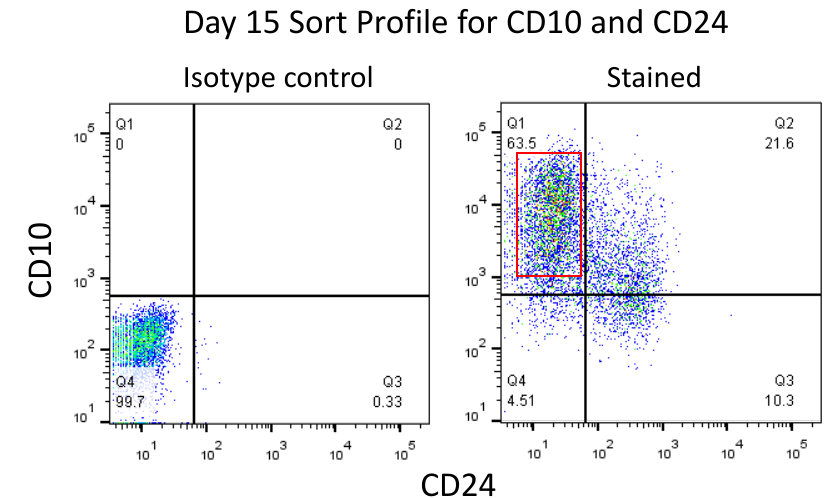
Figure 2. Morphology and sorting profile of hiPSC-derived myogenic progenitors during differentiation timeline. ( A ) Brightfield images demonstrate cell morphology density and transition at different time points during differentiation protocol. Cells become fully confluent at passage (Day 5), sort time point (Day 15) or before terminal differentiation (Day 20). Also note the transition of the cell morphology into spindle/myoblast shape at later stages after sort (Days 16–20) and their elongation into myotubes during terminal differentiation (Days 21–25). Scale bars: 100 µ m. ( B ) Dot plots indicate proper differentiation of the cells at day 15 with formation of a distinct CD10 + CD24 − cell population (marked with red box). Based on the iPSC type (healthy or patient derived), this percentage might be varied from 40–65% in an ideal differentiation condition.